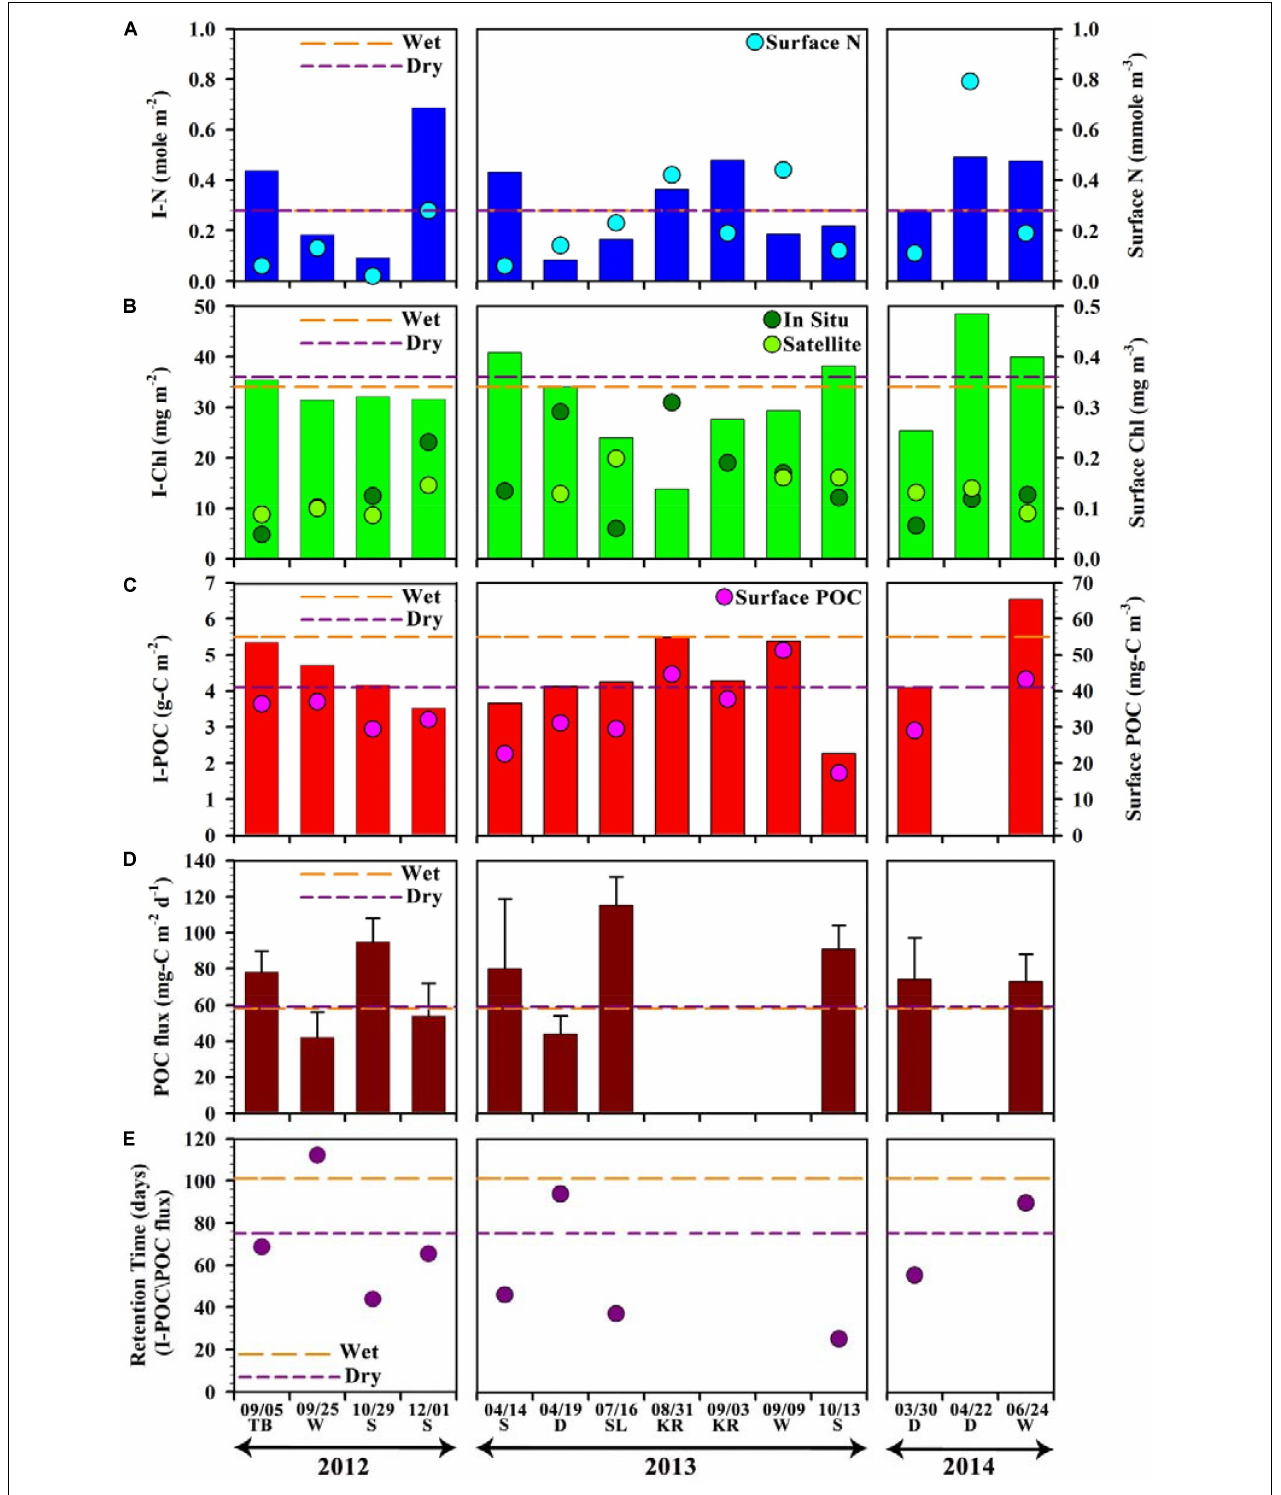
FIGURE 4 | Integrated (0–150 m) and surface values of N (A) , Chl (B) , and POC (C) are shown for each of the 14 sampling dates. POC fluxes (D) were measured at 150 m depth, i.e., below the euphotic zone; thus retention times (E) represent the fractional residence times of POC in the upper 150 m with respect of settling out of particulate organic matter. Dashed lines represent average values in the wet (orange) and dry (purple) seasons. TB, SL, KR, S, D, and W stand for typhoons Tembin , Soulik , Kongrey , storms, dry, and wet seasons, respectively.